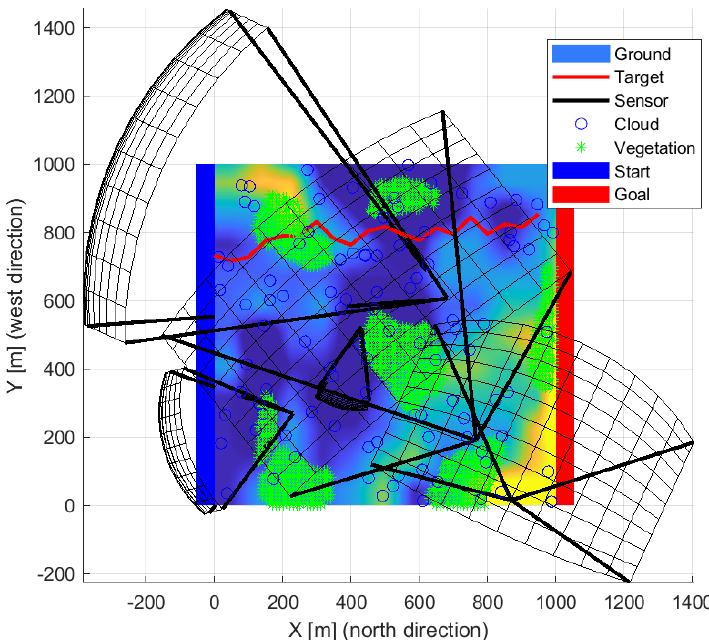
Figure 17. The solution in the case of the five sensors from